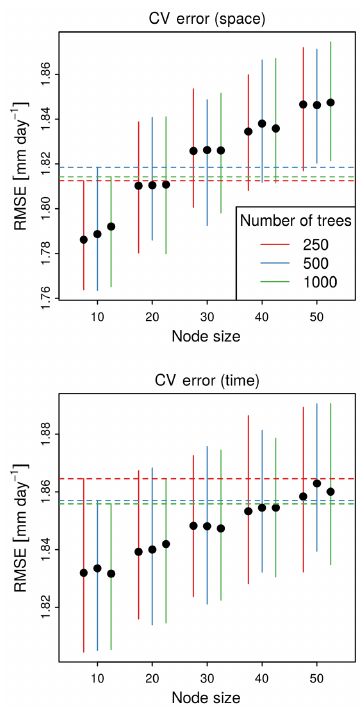
Figure 9. Cross-validation error different values of the nose size parameter ( n ) and different number of trees ( B ). The two panels show results for cross validation in space (top) and cross validation in time (bottom). Shown is the root mean square error (RMSE) to- gether with 95% confidence intervals. Vertical lines indicate 95% confidence interval of the RMSE. Dashed horizontal lines indicate the upper confidence interval for n =